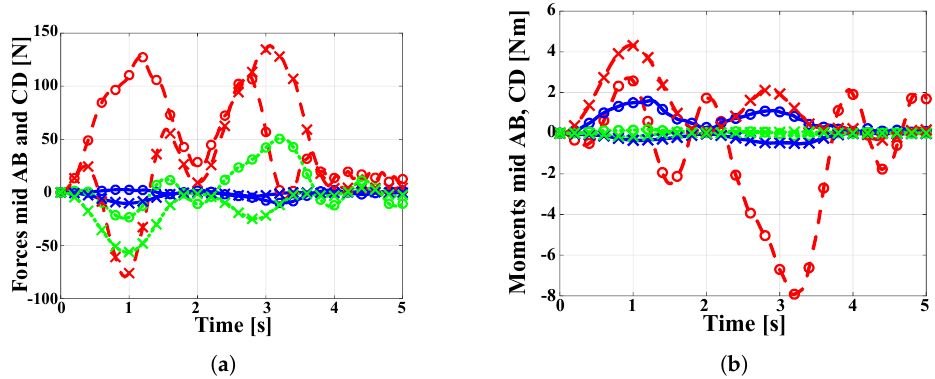
Figure 14. Mid-point stress resultants for BeamAB ( ◦ ) and BeamCD ( × ). ( a ) Axial force F 1 (dashed line), shear forces F 2 and F 3 (solid and dotted lines, respectively). ( b ) Torque M 1 (dashed line), bending moments M 2 and M 3 (solid and dotted lines, respectively).